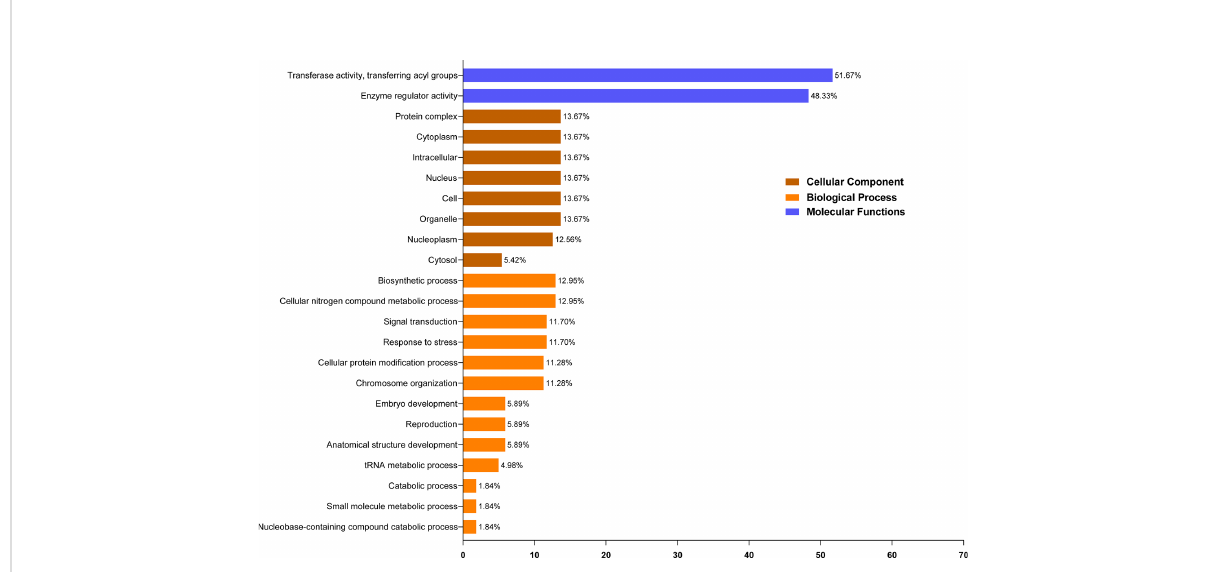
FIGURE 4 GO enrichment analysis of ELP4 genes. Based on functions, these are classi fi ed into three groups (molecular functions, biological processes, and cellular components) and represented through different colors. GO, gene